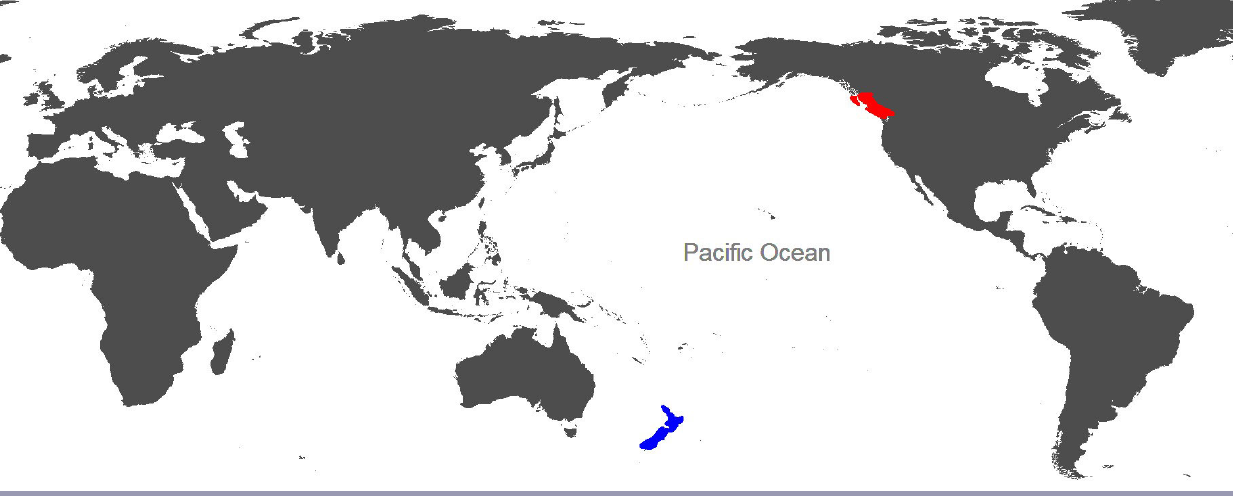
Fig. 1 . Location of Aoteraoa (New Zealand) in blue, home to the M ā ori, and the West Coast of British Columbia, Canada, in red, home to many individual Coastal First Nations, referred to collectively herein as “Coastal